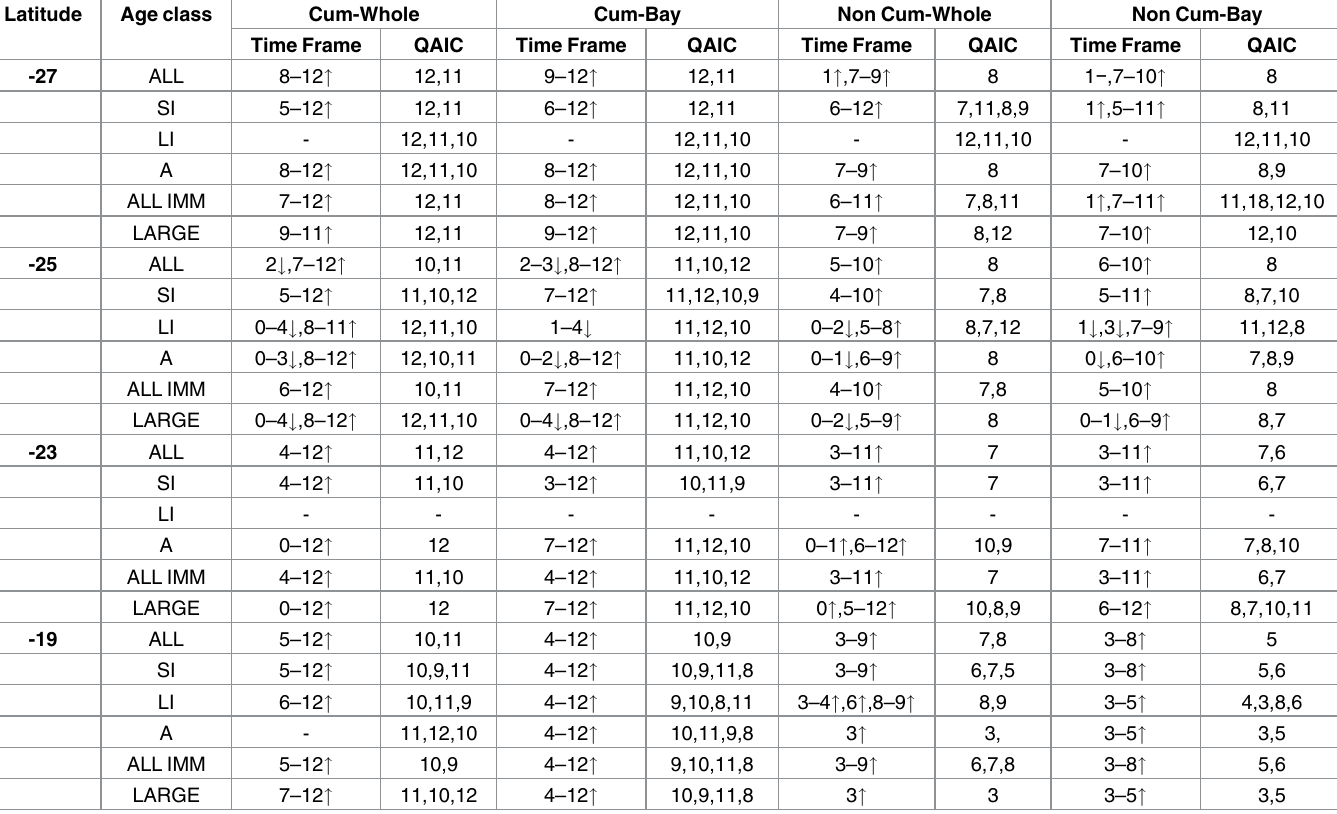
Table 11. Model results for all turtles and mean discharge. " denotesincreasedstrandingsrates with increaseddischarge. # denotesdecreasedstrand- ing rates with increaseddischarge.Age class abbreviations:ALL = all turtles, SI = small immature, LI = large immatures, A = adult-sized,ALL IMM = all imma- ture sized animals(small + large), Large = all large turtles (large immatures + adult-sized). The time frame is reportedin monthly ranges where responses were noted. The values reportedin qAIC are the months with the most significantqAIC